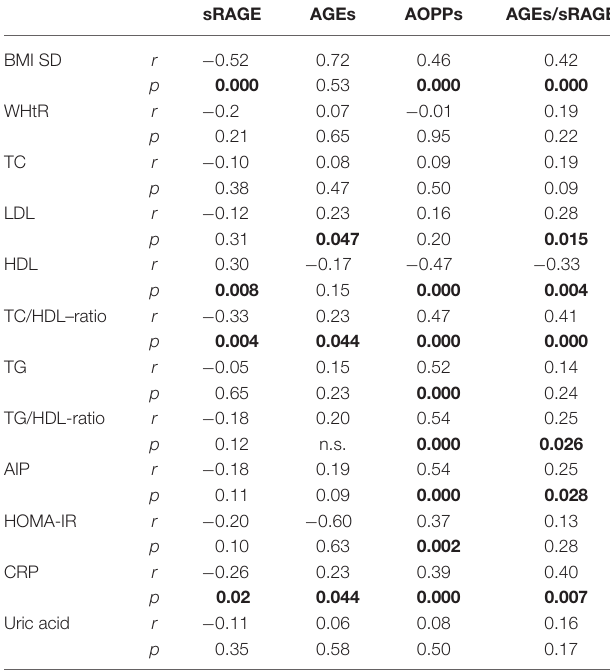
TABLE 2 | Correlation analysis among oxidative stress markers and cardio-metabolic risk factors (Spearman’s test). sRAGE AGEs AOPPs